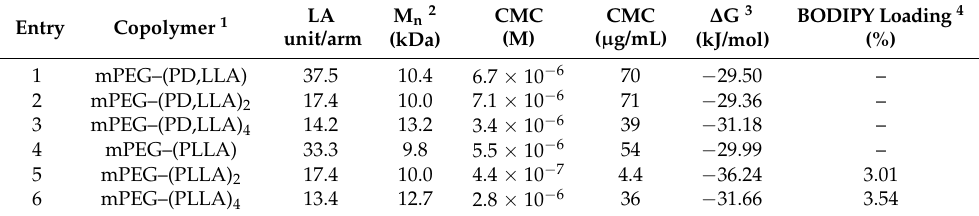
Table 1. Chemical structure, lactide content, and molecular weight (M n ) of copolymers. Critical micelle concentration (CMC) and ∆ G formation of the corresponding